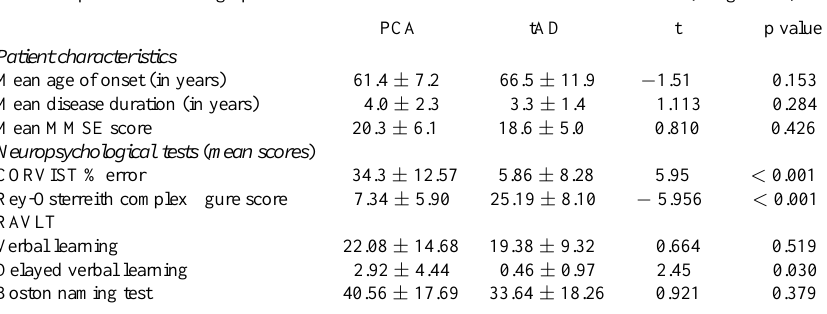
Comparisons of demographics and continuous scores for PCA versus tAD cases (using t-tests)